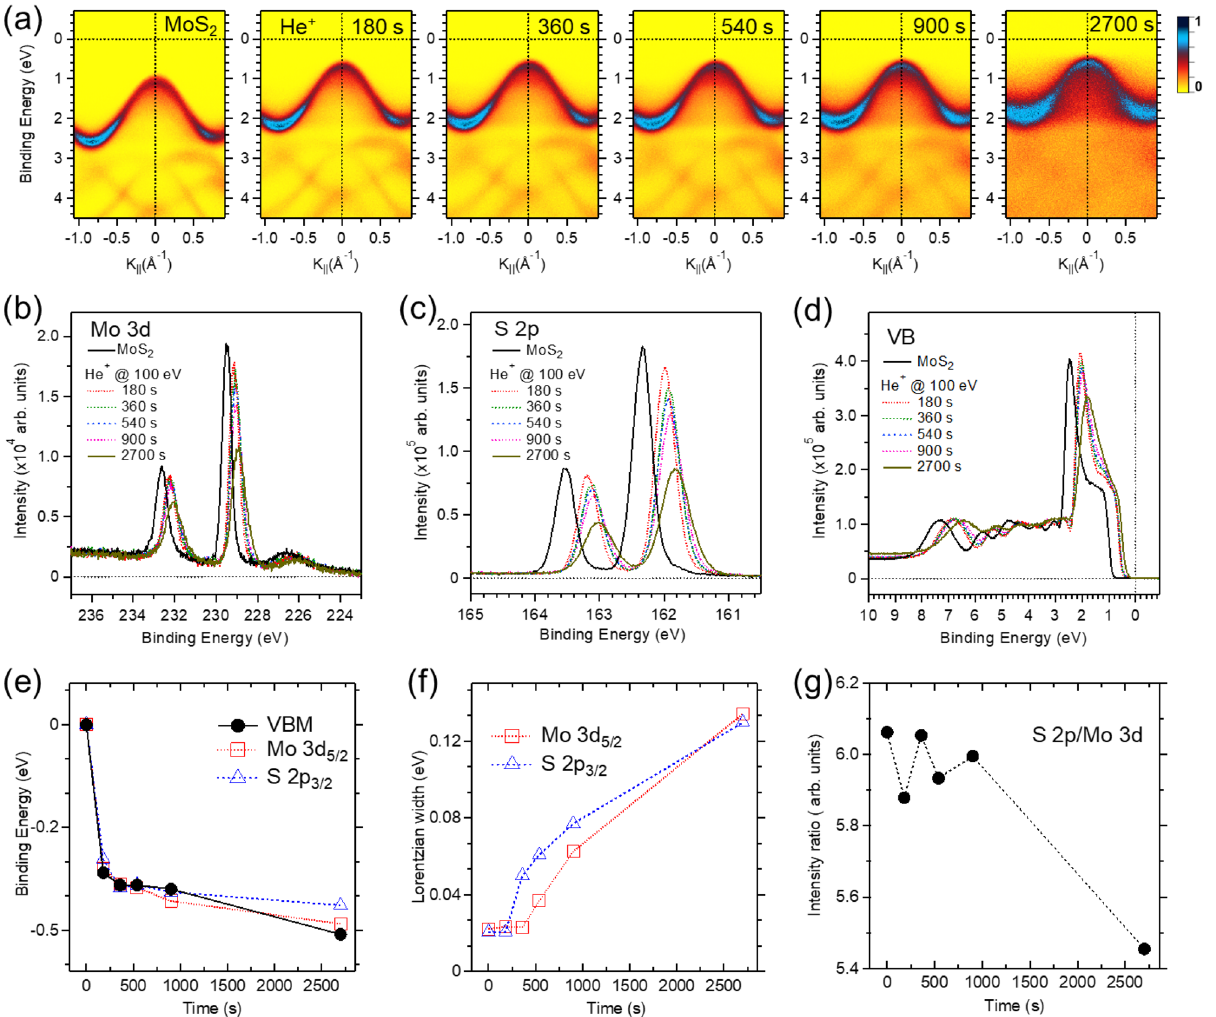
Figure 2. ( a ) ARPES intensity maps along the M Ŵ K symmetry lines were taken at the photon energy of hν = 56 eV. The overall band structure of the freshly cleaved n-type surface of the MoS 2 single crystal moved upward from left to right as a function of the He + ion irradiation time at the fixed low ion energy of 100 eV. ( b – d ) Comparison of Mo 3 d , S 2 p , and valence-band photoemission spectra taken at the respective photon energies of hν = 300 eV, 222 eV, and 56 eV. ( e ) Binding energy shifts of the prominent Mo 3 d 5/2 and S 2 p 3/2 peaks and the VBM. The binding energies of the cleaved MoS 2 surface are 229.50 eV, 162.34 eV, and 0.87 eV, respectively. ( f ) Comparison of Lorentzian linewidth of Mo 3 d and S 2 p core-level spectra. ( g ) The intensity ratio of S 2 p to Mo 3 d core-level